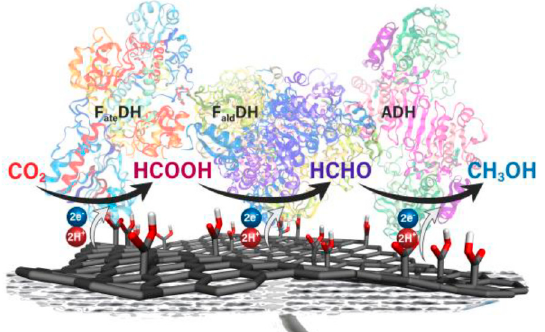
Figure 11. The cofactor-free biosynthesis of methanol using formate dehydrogenase, formaldehyde dehydrogenase and alcohol dehydrogenase. Reprinted from [168] Copyright (2020), with permission from the American Chemical Society.